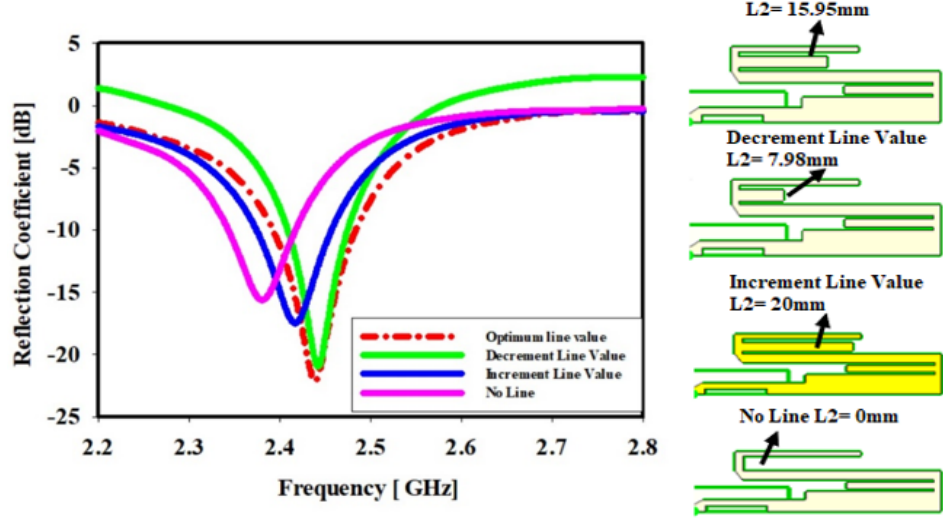
Figure 5. Middle meander line length effect: the sketches on the most ‐ right side in Figure 5 show the geometries of the meander line changes.